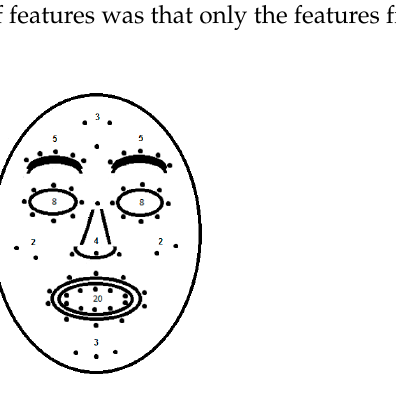
Figure 3. Tracked features using face tracking API. The 60 features were chosen from the expressive part of the face.